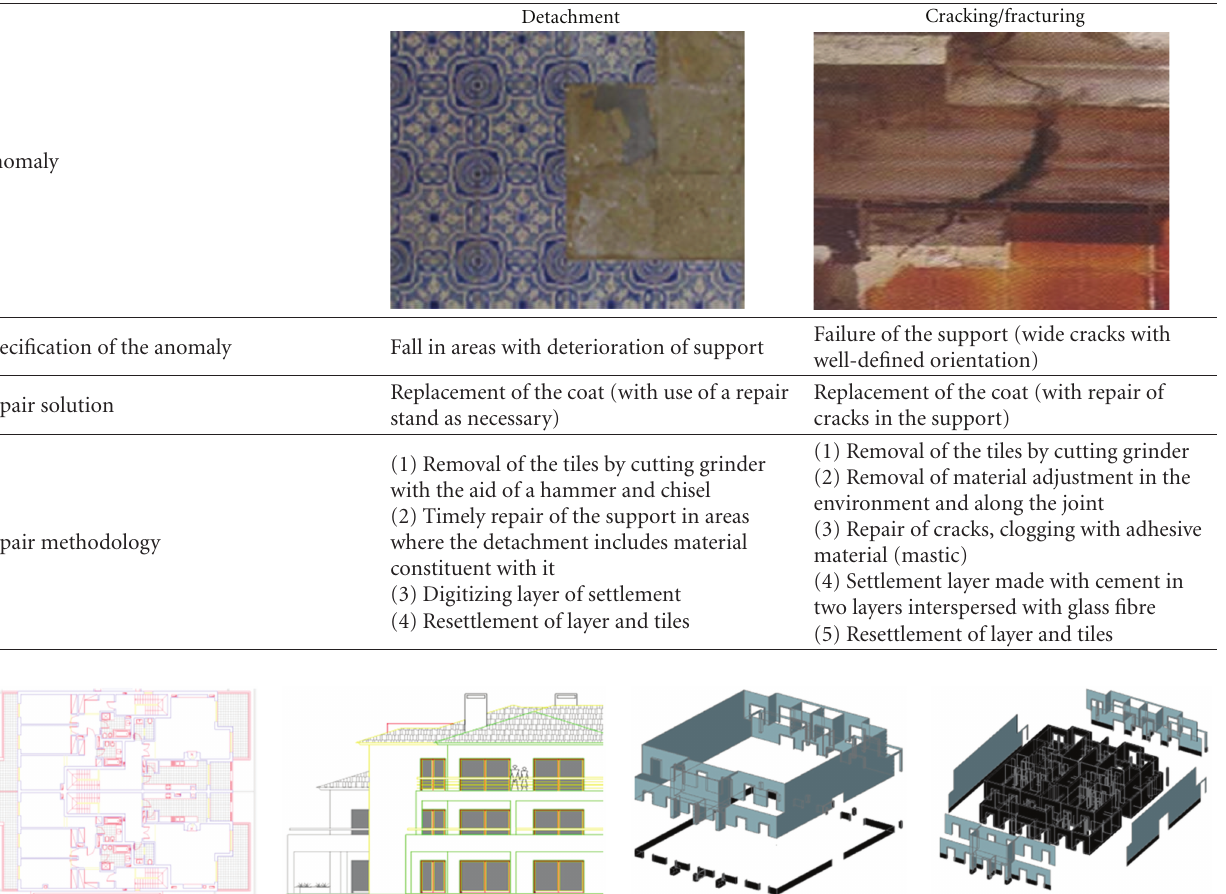
Table 3: Example of anomalies and the associated repair solution.